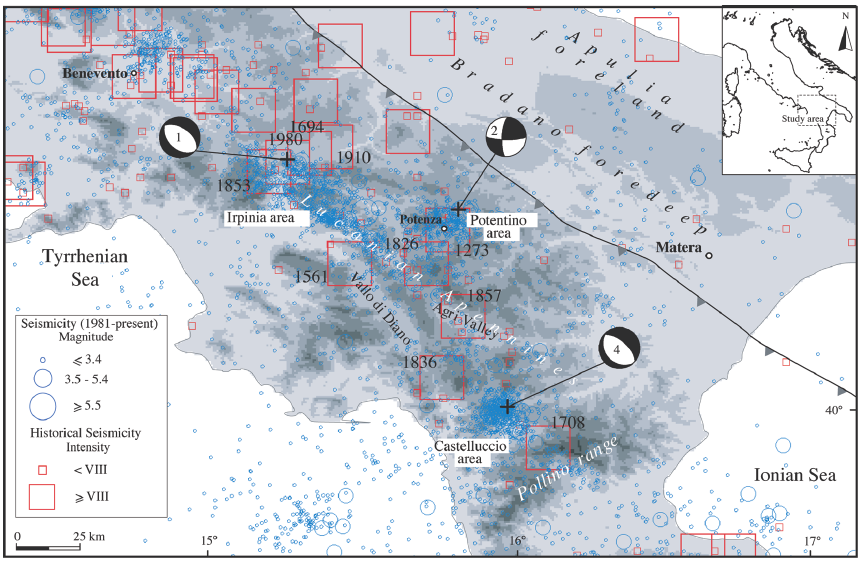
Fig 1. Seismicity map of Southern Italy (Castello et al., 2005; CPTI Working Group, 1999) from 1981 to pres- ent. The dates of occurrence for the largest events are indicated. The available CMT (Centroid Moment Tensor) solutions of the earthquakes of M ≥ 5.0 are also shown (Pondrelli et al. , 2002). Numbered focal spheres corre- spond to events in table